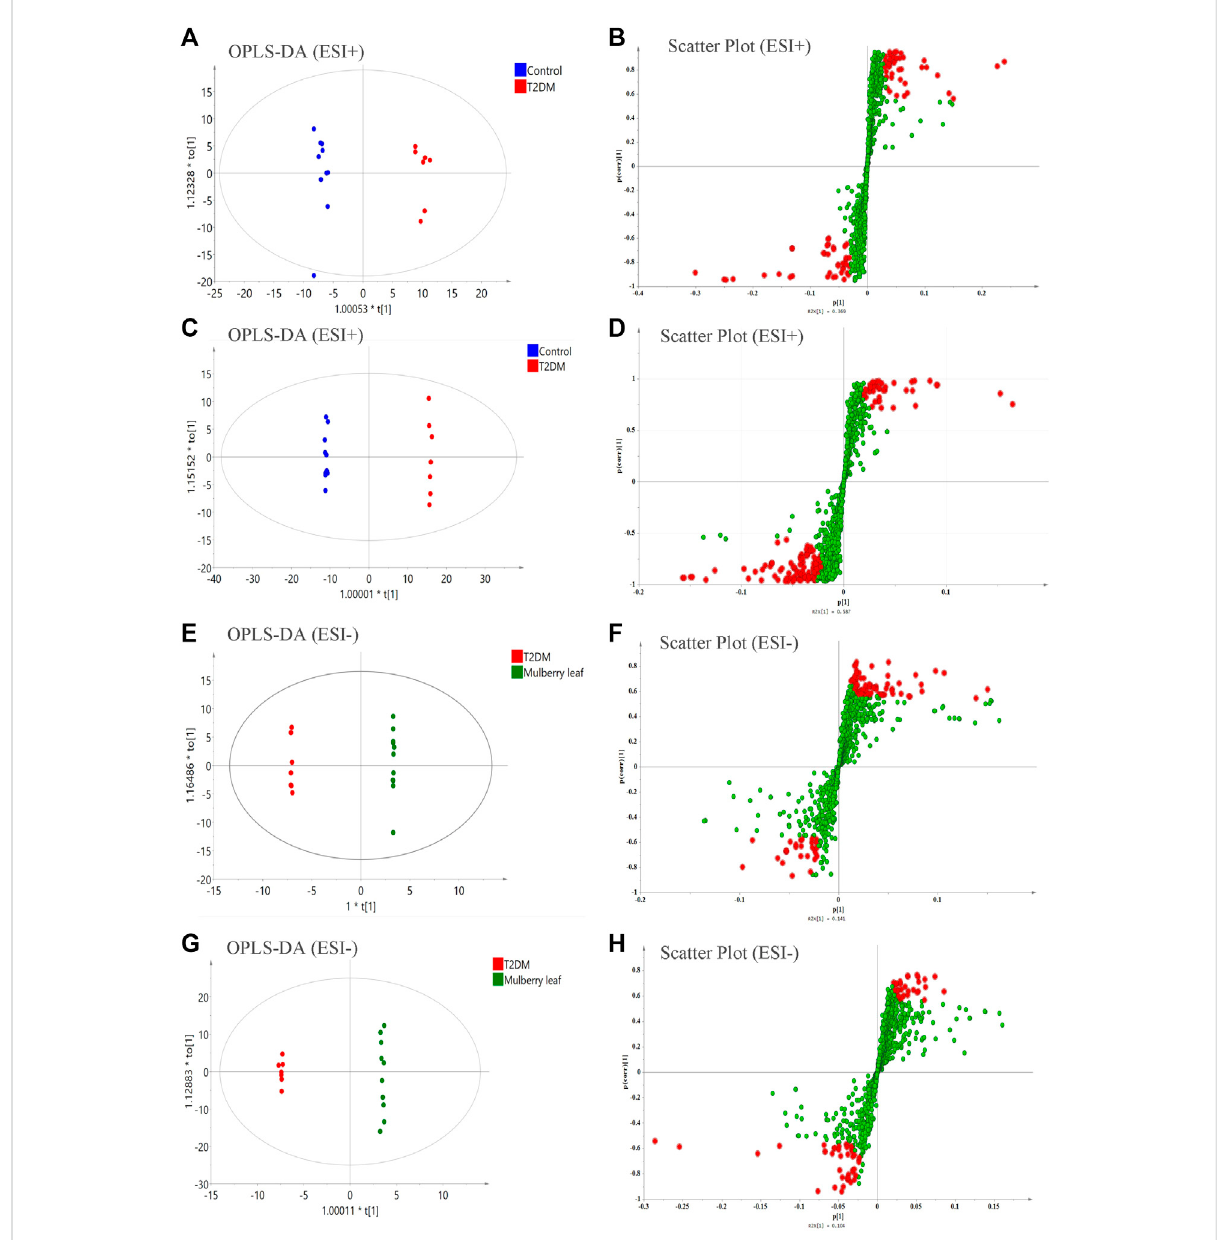
FIGURE 5 Theorthogonalpartialleastsquaresdiscriminantanalysis(OPLS-DA)scoreplots,S-plotsoftheserummetabolomicsanalysis (A – D) ESI+model (E – H) ESI-